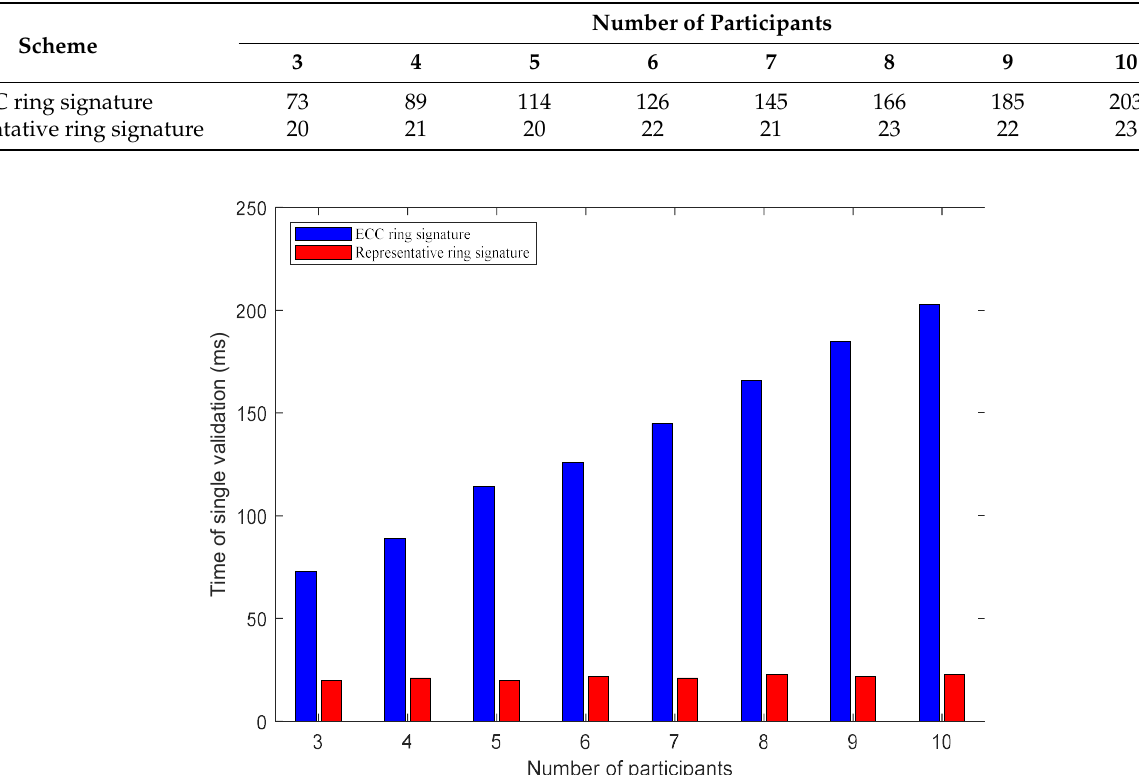
Figure 8. The computational speed comparison for a single validation between two schemes.